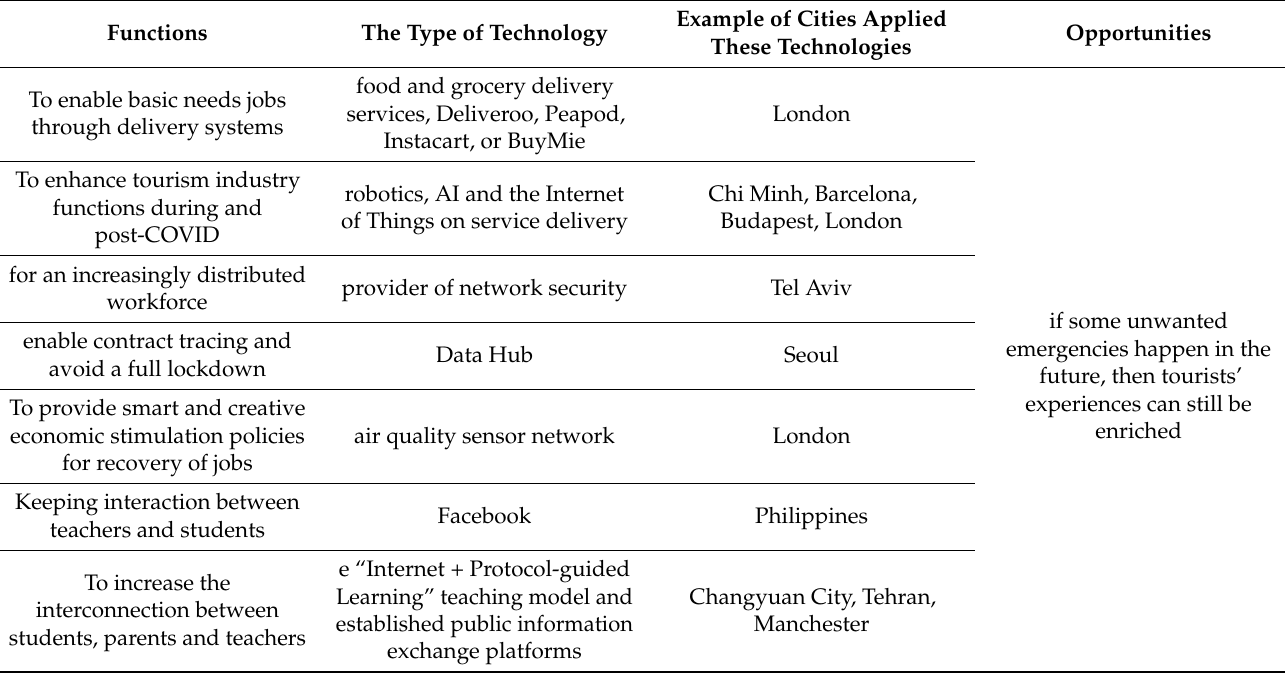
Table 3. Technology deployment and functions to improve education and employment during